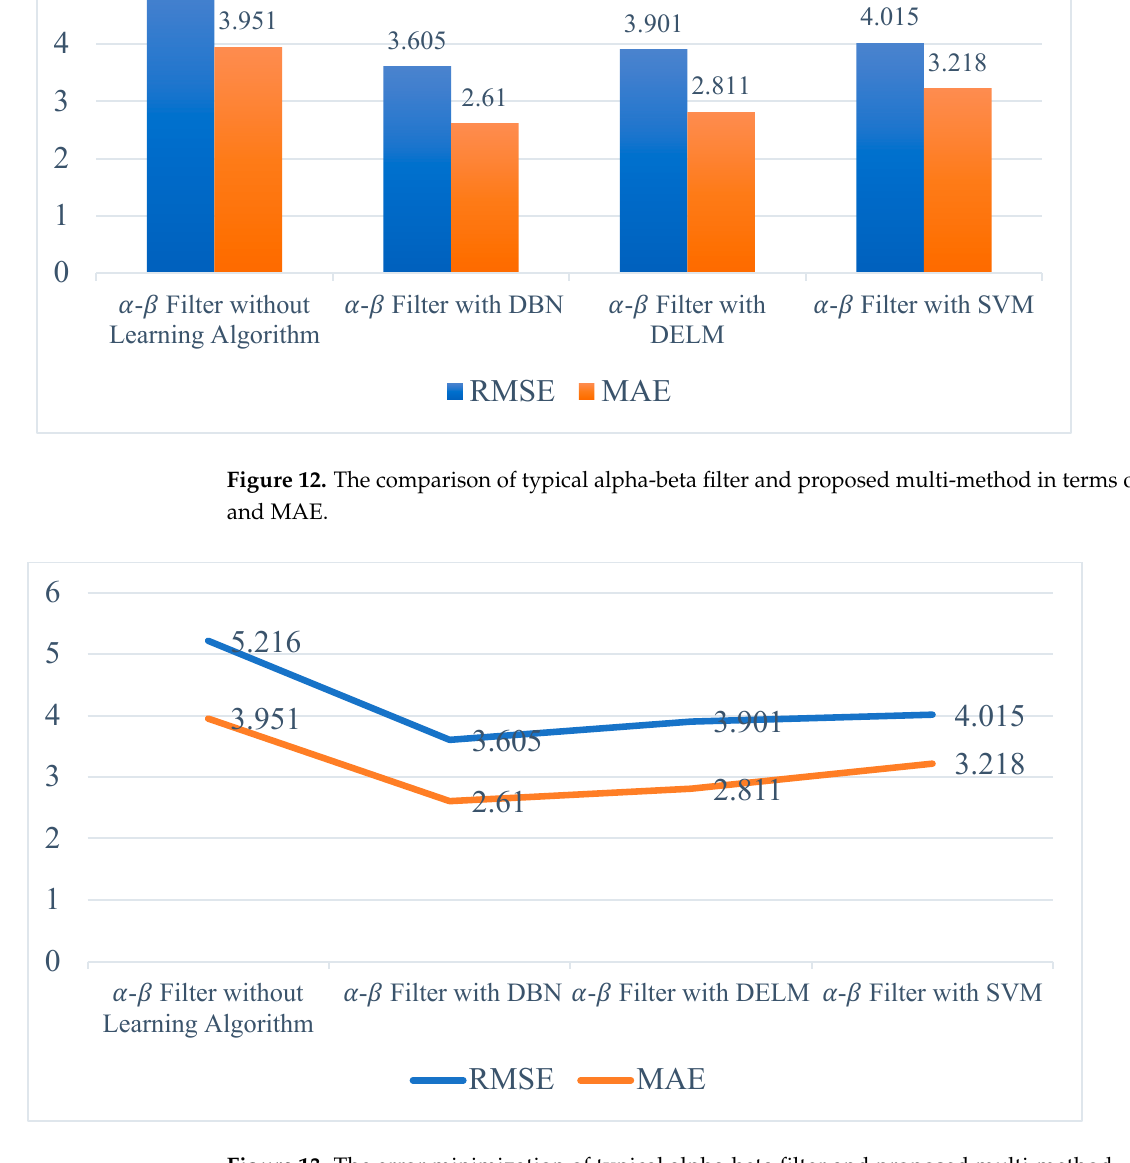
Figure 13. The error minimization of typical alpha-beta filter and proposed multi-method.